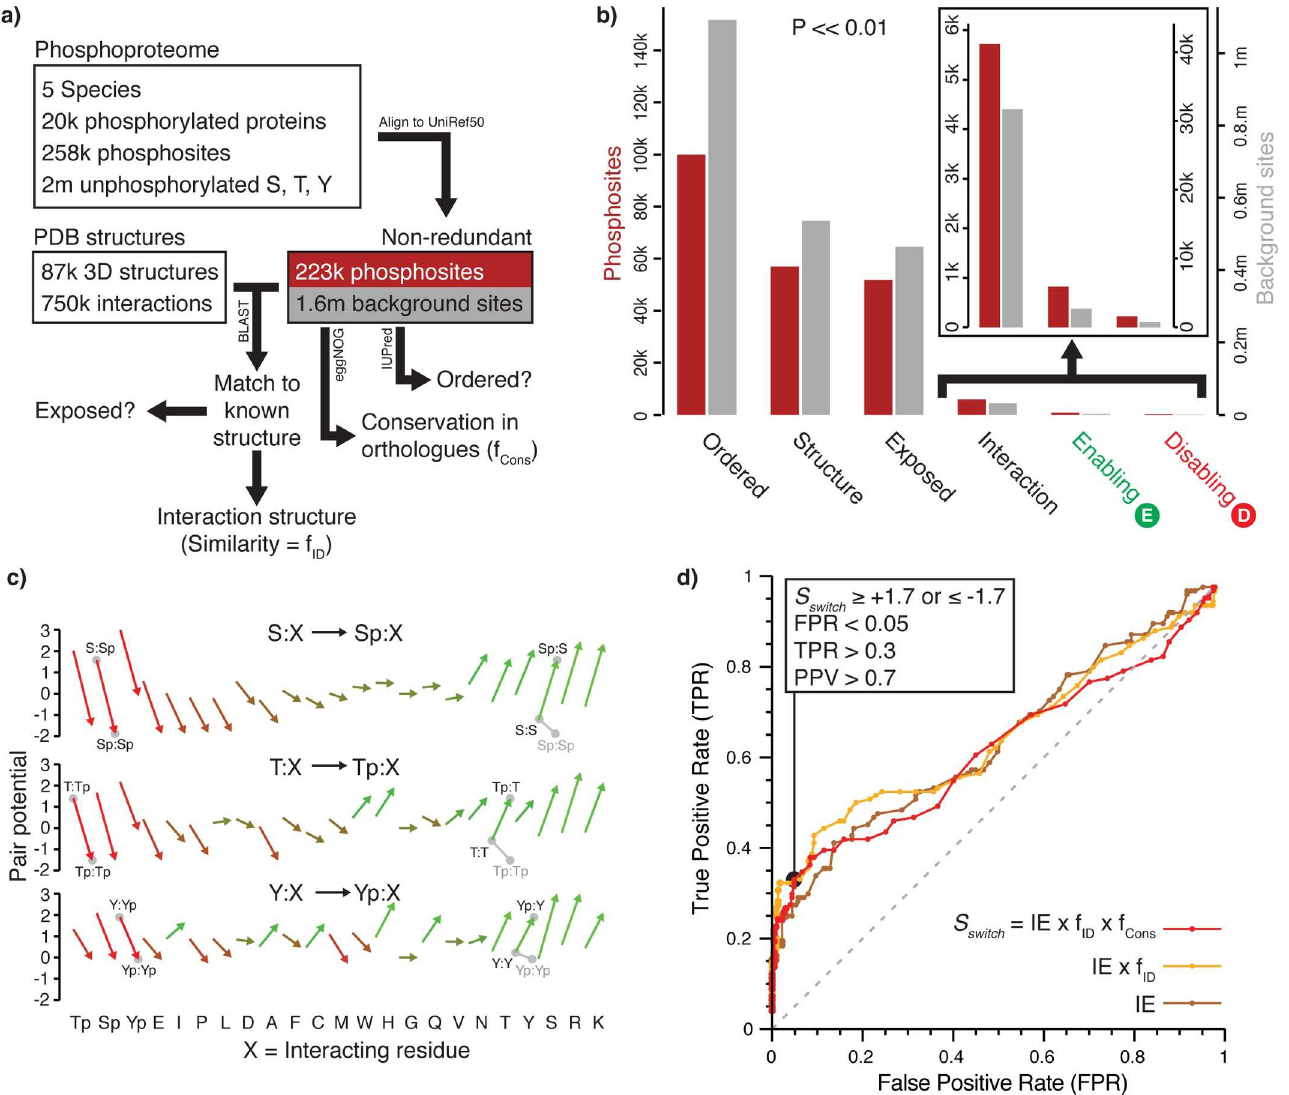
Fig 1. Summary of the data processing pipeline and results. a) Source data and processingsteps. b) Summary of counts of phosphosites (red bars, left-hand y-axis) and background sites (grey bars, right-handy-axis) that are ordered,matched to a template structure, were surface exposed,in an interactioninterface, and predictedto be enablingor disablingby S switch . The left and right-handaxes are scaled to the total numberof non- redundantphosphosites and background sites, respectively. The difference betweenthe fractions of phosphosites and background sites for